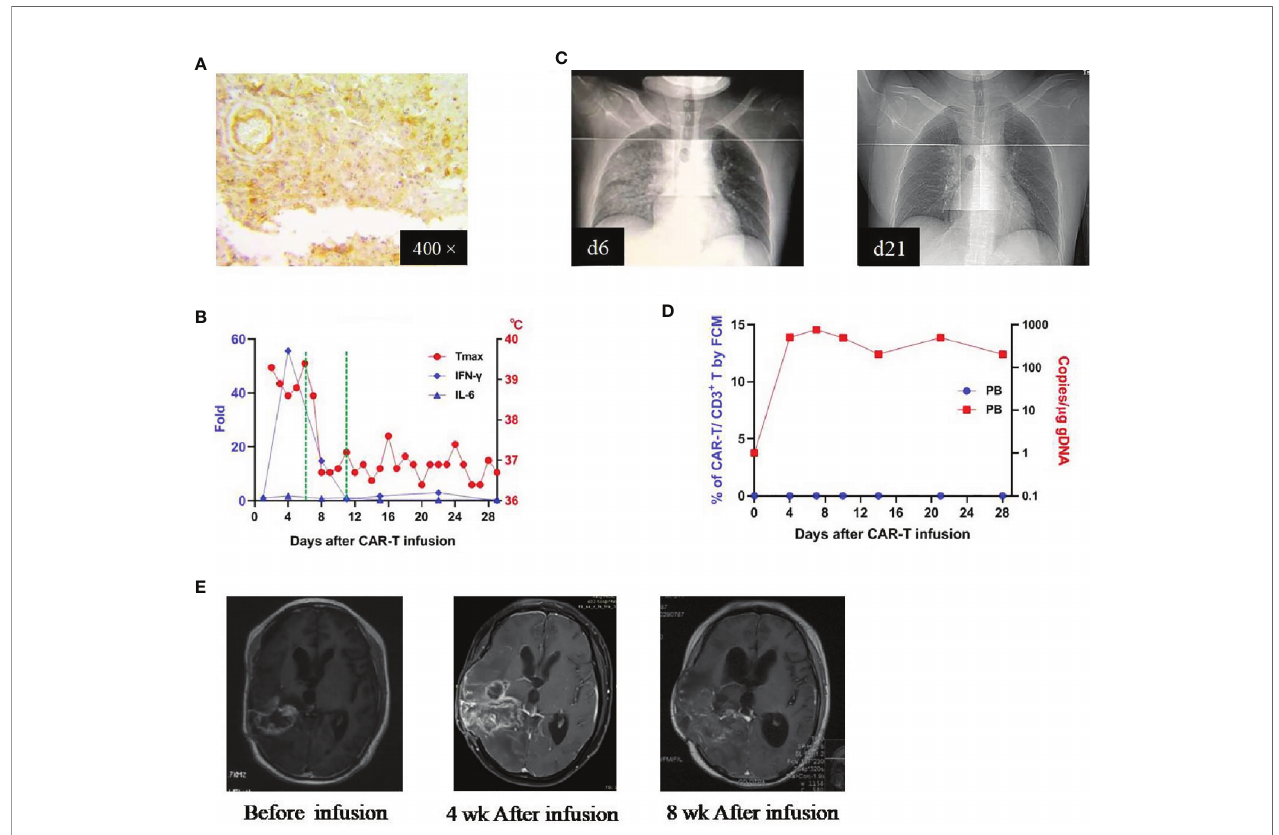
FIGURE 4 | IHC staining of the tumor and clinical response in patient 3. (A) Anti-EphA2 IHC staining of tumor tissue before enrollment. (B) Dynamic changes of critical cytokines in the peripheral blood along with temperature, after the infusion of CAR T-cells. The dotted green line on the x-axis indicating the time window for the use of dexamethasone. (C) Thoracic X-ray performed on days 6 and 21 after the infusion of CAR T-cells, showing the development and resolution of pulmonary edema in the right middle and inferior lobes. (D) Expansion of CAR T-cells in the peripheral blood by fl ow cytometry (left y-axis) and qPCR (right y-axis). (E) Contrast- enhanced MRI performed before and after (4 and 8 weeks) the infusion of CAR